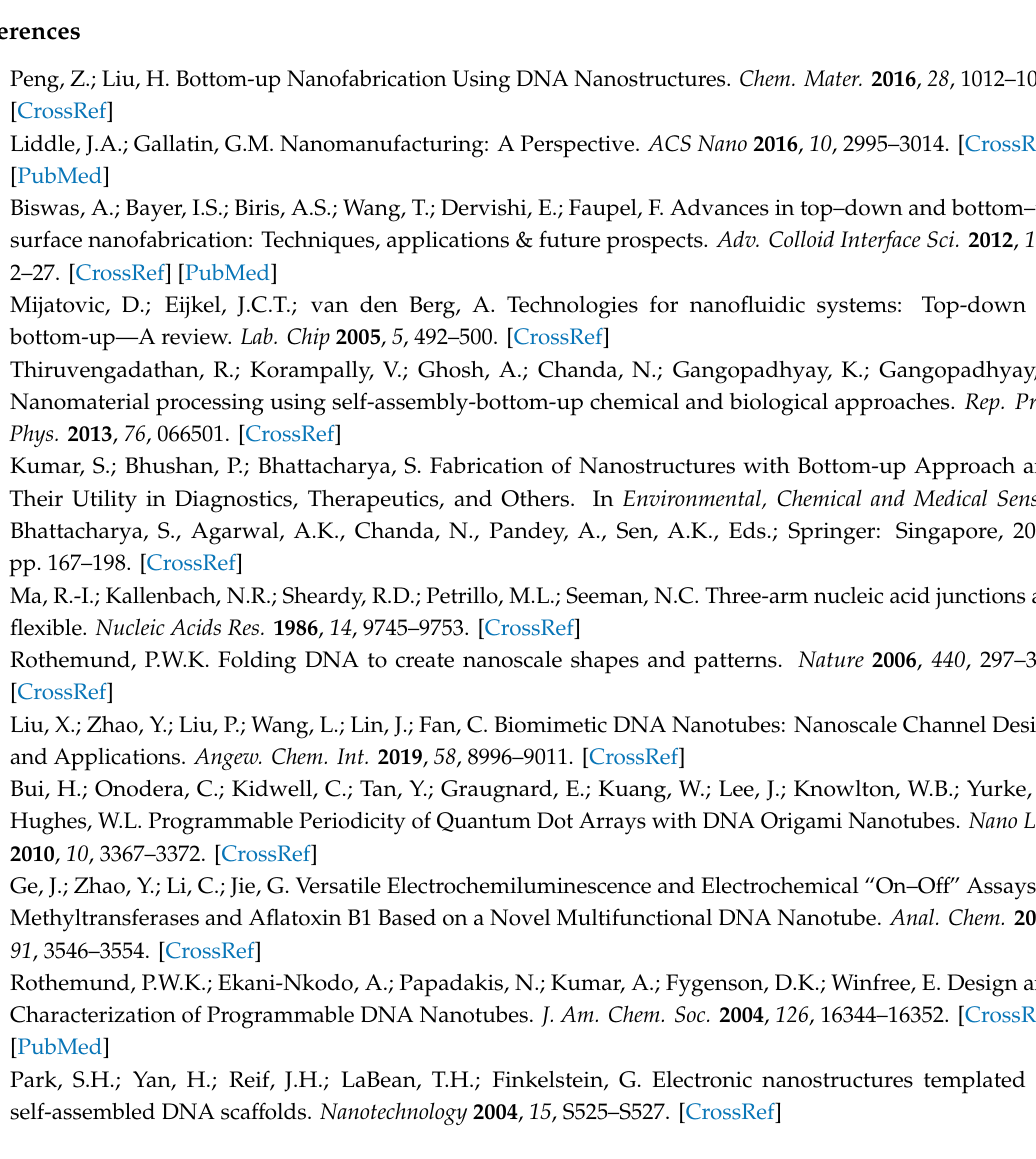
Supplementary Materials: Scheme S1: DNA nanotube tile sequences, Figure S1: AFM height characterization, Figure S2: SEM images of Au nanorods seeded and then plated with commercial Au plating solution, Figure S3: Blank experiment to assess overspray or substrate resistance, Figure S4: Control experiment connecting 4 Au pads to an EBID-written